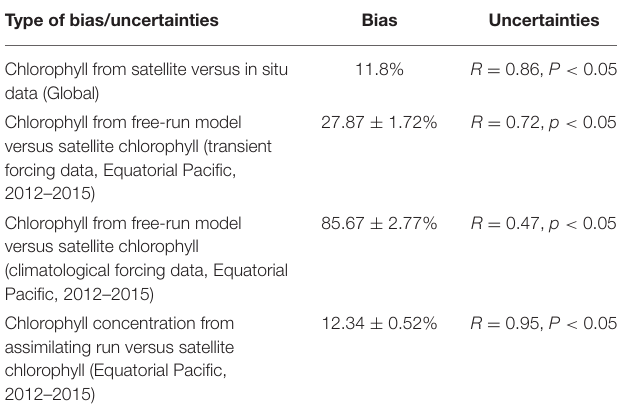
TABLE 1 | Summary table of bias and uncertainties of the various elements of the system used to